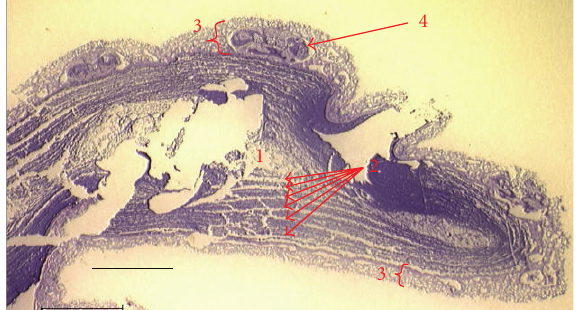
Figure 28: Longitudinal section of Corallium konojoi ; OCA- Cn20071106-006. 1: center of the axis, 2: growth rings, 3: coenen- chyme, 4: autozooid. Scale bar is 1.0 mm.